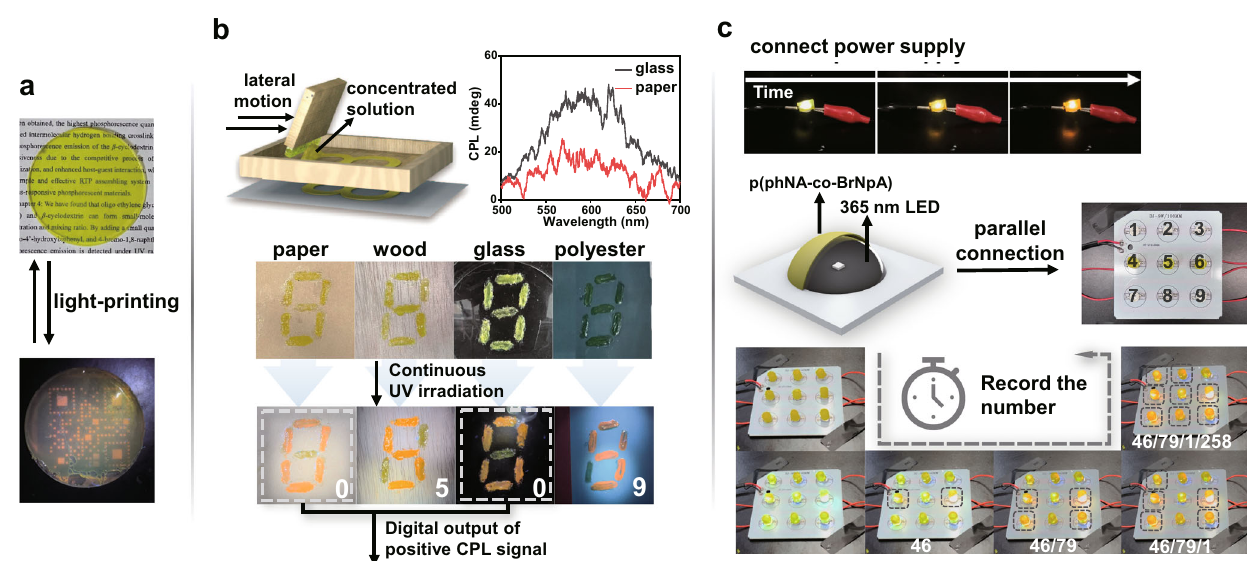
hidden pattern was printed again using p( R/S -phNA 7 BrNpA 3 )-PMMA. Photographs of hidden pattern taken under UV irradiation (bottom). c Photographs of the